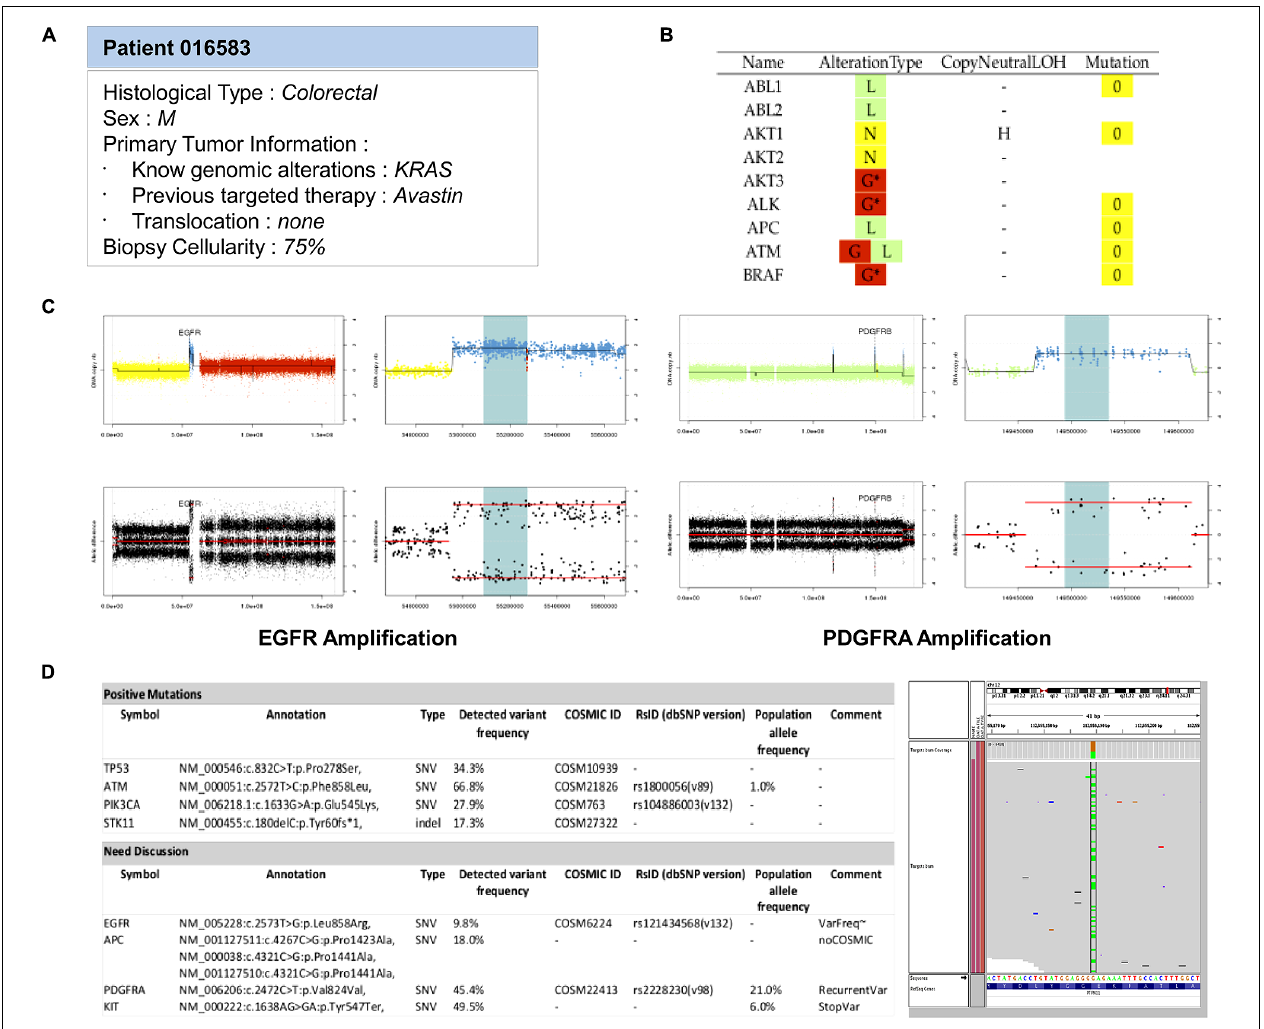
FIGURE 5 | Example of the main features reported in the MBB report. (A) Patient information. All available clinical and biological informations about the patient are reported to guide the therapeutic decision. (B) Summary of molecular abnormalities. DNA copy number and mutations statuses for all genes are reported in a main table in order to provide a quick overview of the potential targets.The DNA copy number (D = Deletion, L = Loss, N = Normal, G = Gain, A = Amplification) and the mutations statuses are color-coded to ease the interpretation. (C) DNA copy number status. For each